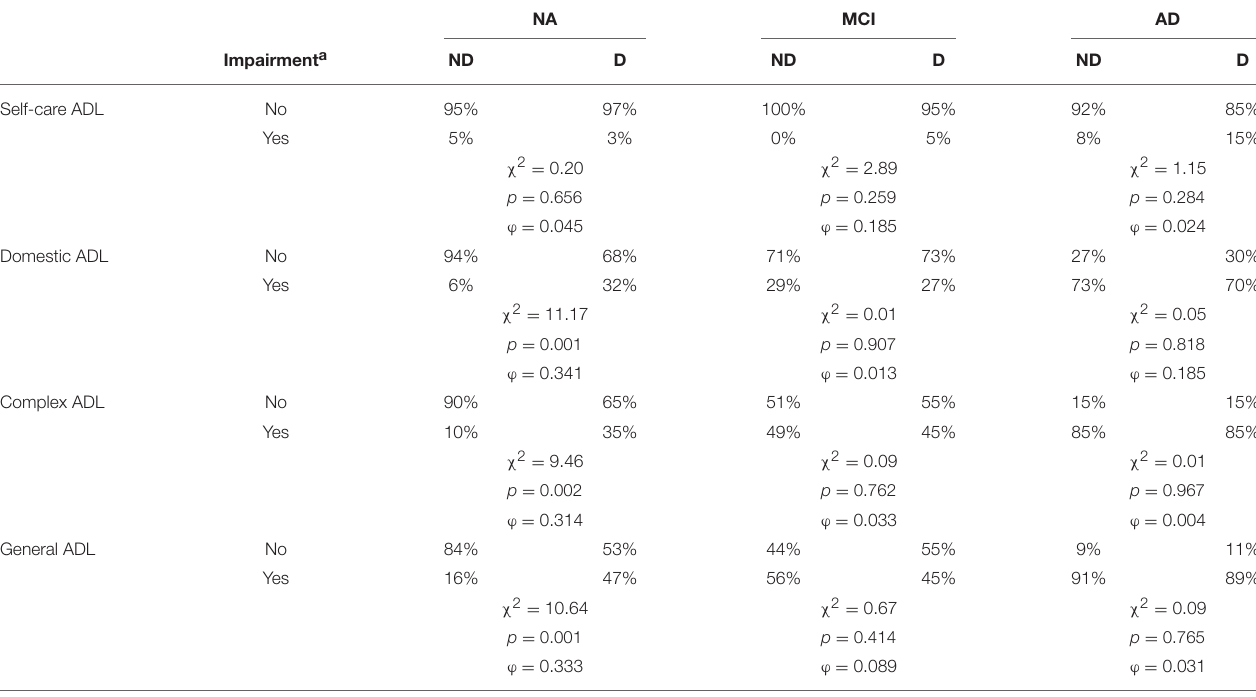
TABLE 5 | Frequency of impairment in at least one activity of daily living in each group and group comparison’s (chi-square test) between depressed and non-depressed participants. NA MCI